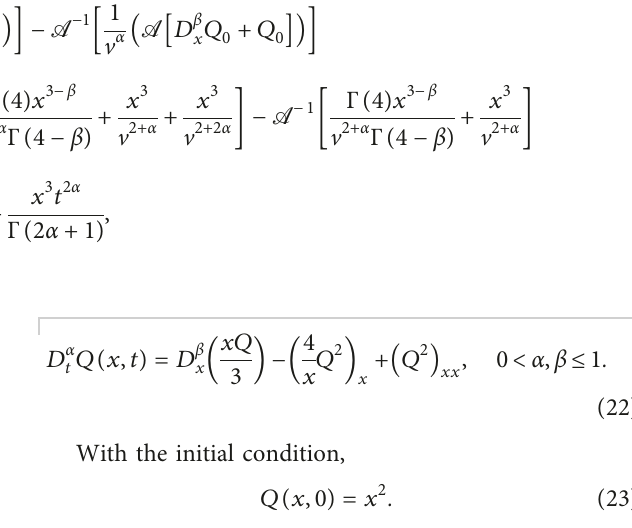
Figure 1 represent the solution plots of equation (16) when α � β � . 02 , . 04 , . 06 , . 08 , 2 , . 4 , . 6 , . 8 at x � 1 and t � 1, respectively. While the remaining are the surface